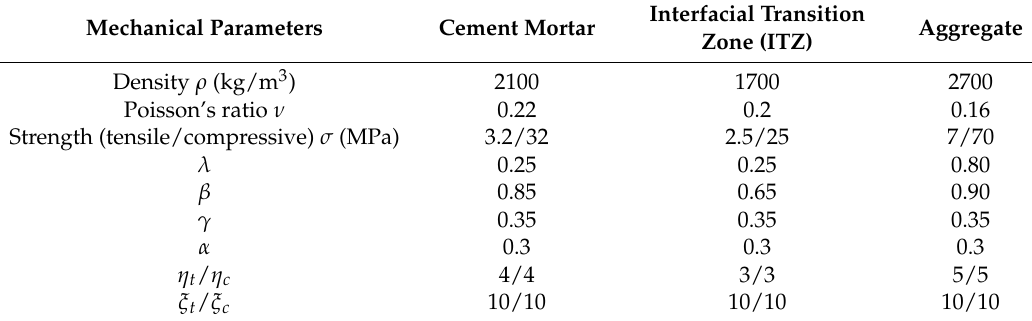
Table 1. Mechanical parameters of